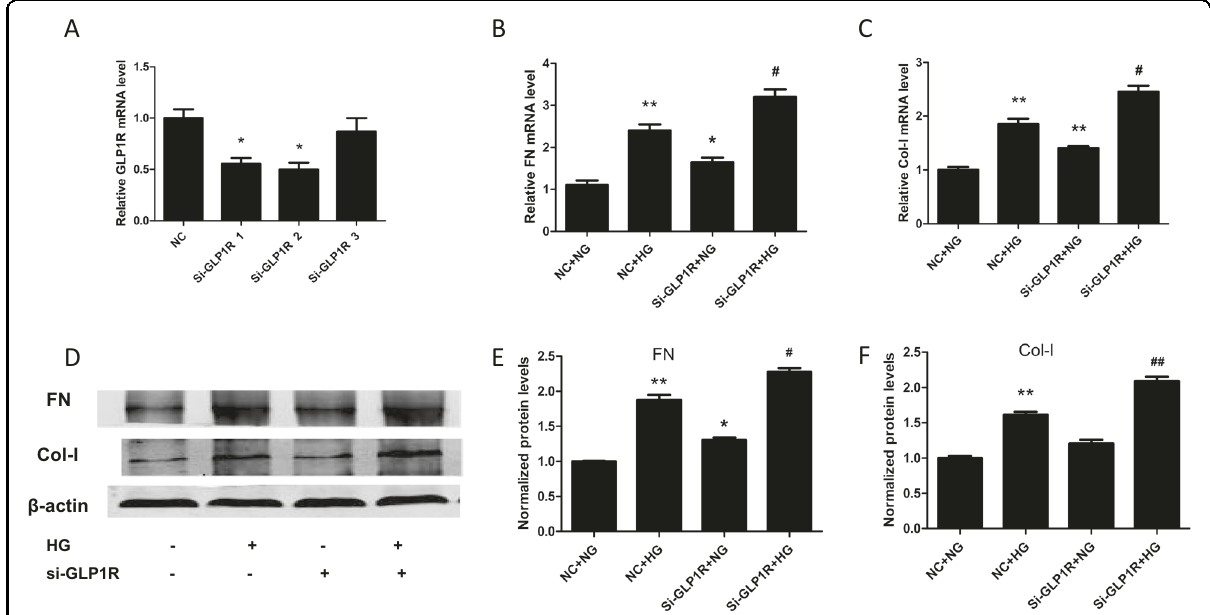
Fig. 7 GLP1R knockdown induced renal fi brosis. a The silencing ability of three si-GLP1R sequences in HK-2 cells (* P < 0.05 versus the NC group). b , c Relative expression of Col-I and FN in HK-2 cells transfected with si-GLP1R and exposed to HG. d – f Col-I and FN expression in HK-2 cells transfected with si-GLP1R and exposed to HG was analyzed by western blot (* P < 0.05 and ** P < 0.01 versus the NC + NG group; # P < 0.05 and ## P < 0.01 versus the NC + HG